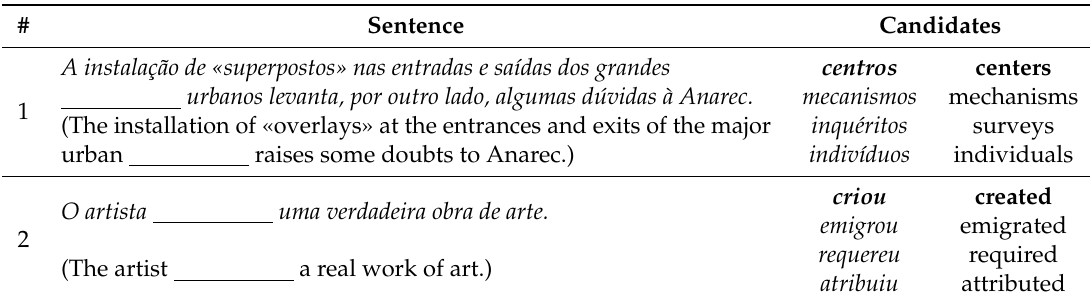
Table 14. First two cloze questions of the dataset